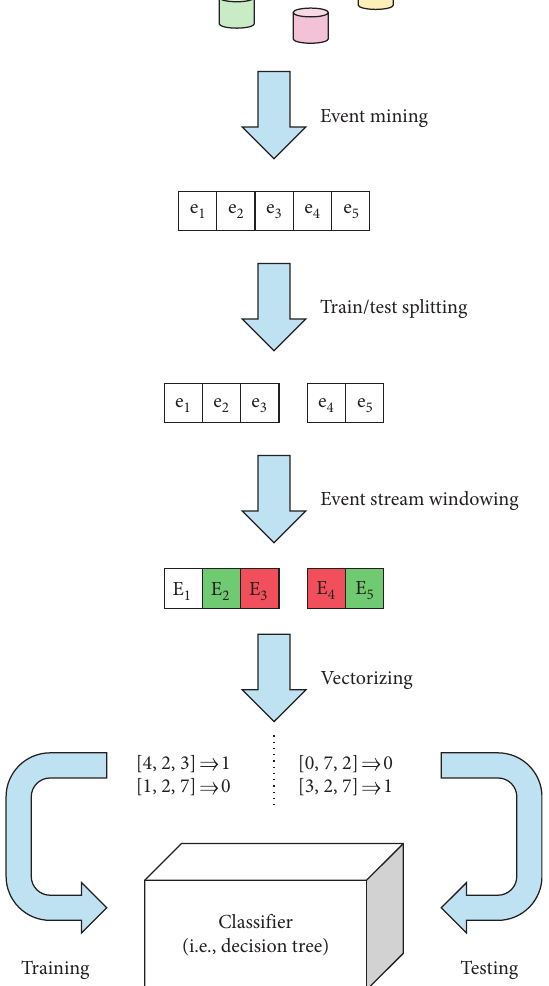
Figure 9: The prediction pipeline. Source: own